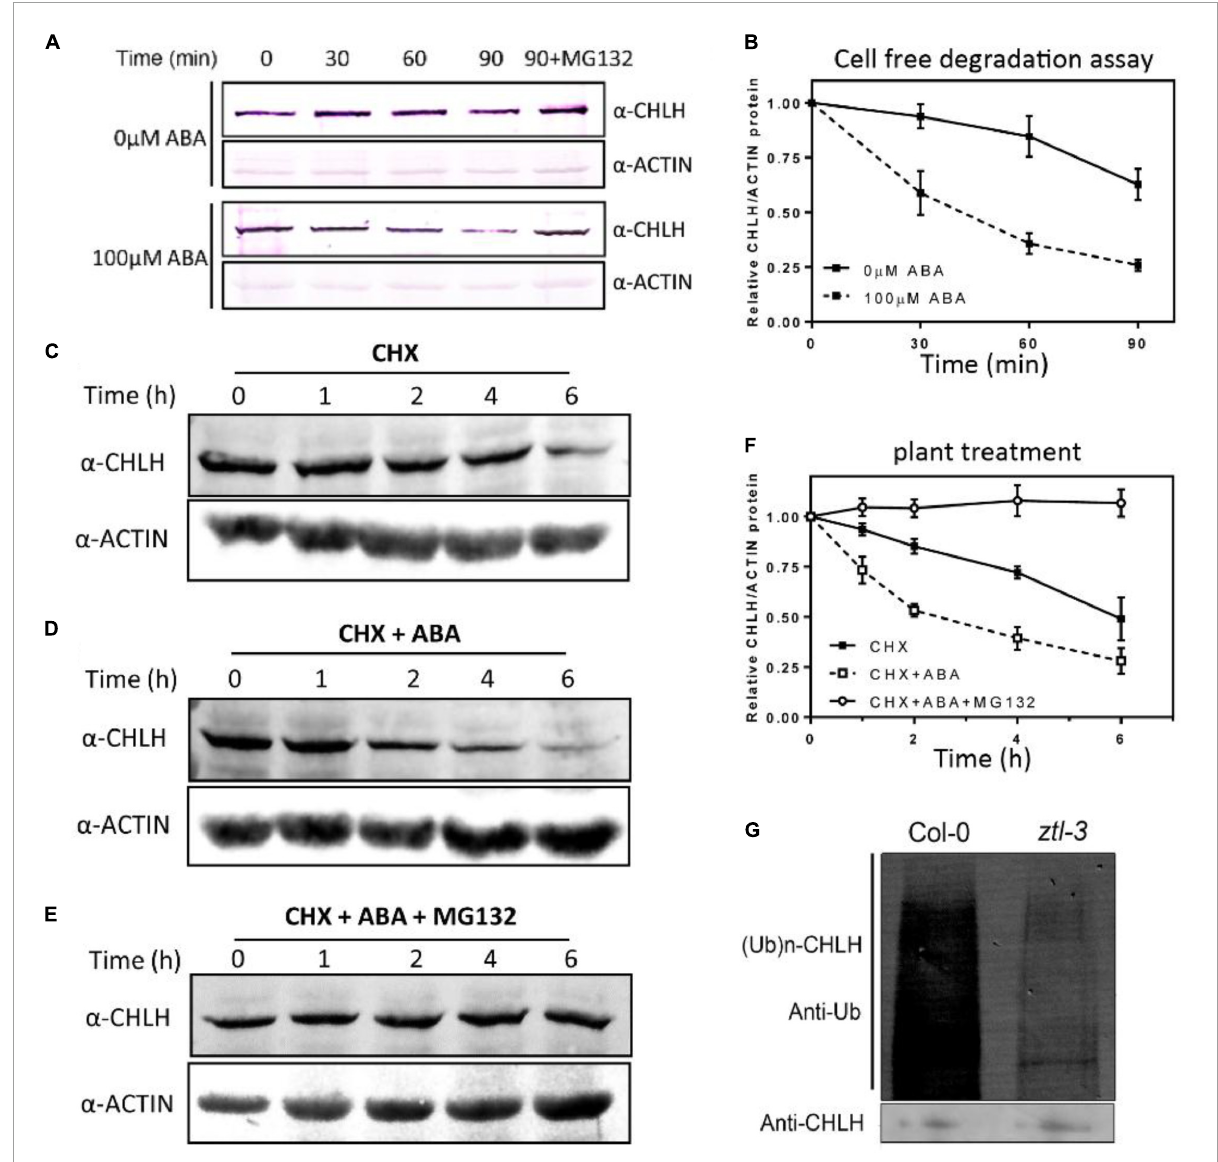
FIGURE4 ABA induces CHLH proteasomal degradation. (A) Immunodetection of CHLH protein in vitro . Seedlings were grown in LgD conditions and treated with or without 100 µ M ( ± ) ABA for 2 h prior to sampling. Protein extracts were incubated at 30 ◦ C in cell-free buffer with or without proteasome inhibitor (MG132) for the indicated time (min). (B) Quantification of CHLH protein abundance in cell-free assays. Data are shown as the means ± SE of three independent experiments relative to the initial value. (C–E) Immunodetection of CHLH protein in vivo . Seedlings were grown in LgD, and seedlings were treated with cycloheximide (CHX) and with or without proteasomal inhibitor (MG132) for 2 h at ZT3. Then, the seedlings were treated with or without 100 µ M ( ± ) ABA. (F) Quantification of CHLH protein abundance in in vivo degradation assays. Data are shown as the means ± SE of three independent experiments relative to the initial value and normalized to ACTIN abundance. (G) Polyubiquitination of CHLH in vivo . Total protein extract was immunoprecipitated with anti-CHLH antibody at ZT19, and precipitated proteins were subjected to immunoblot analysis with anti-ubiquitin antibody (upper panel). Immunoblot analysis of the total protein extract using anti-CHLH antibody as a loading control (lower panel). The experiments were repeated three times with similar results.